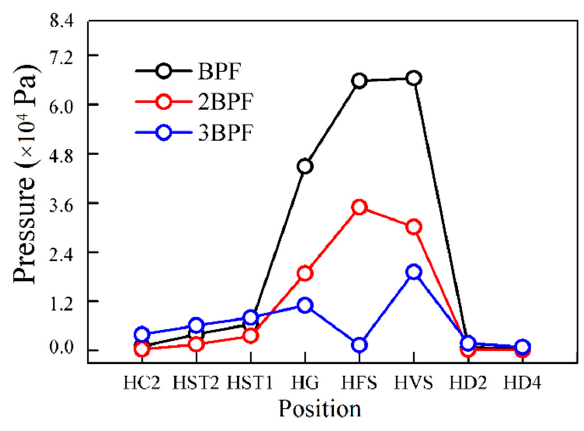
Figure 12. Distribution of frequency components BPF, 2BPF and 3BPF in the middle of flow channels.